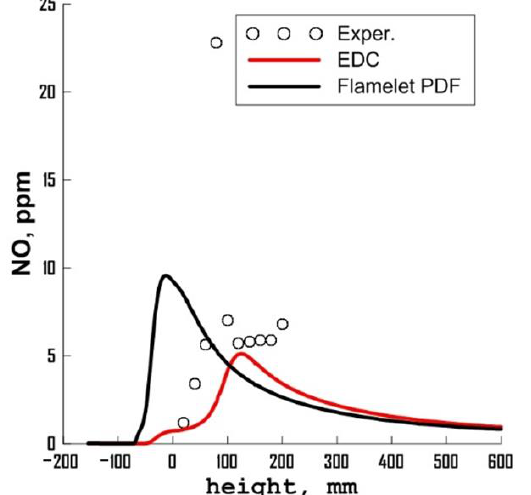
Figure 15. Distribution of temperature and gas composition along the burner axis in experiment and calculation for various combustion models.